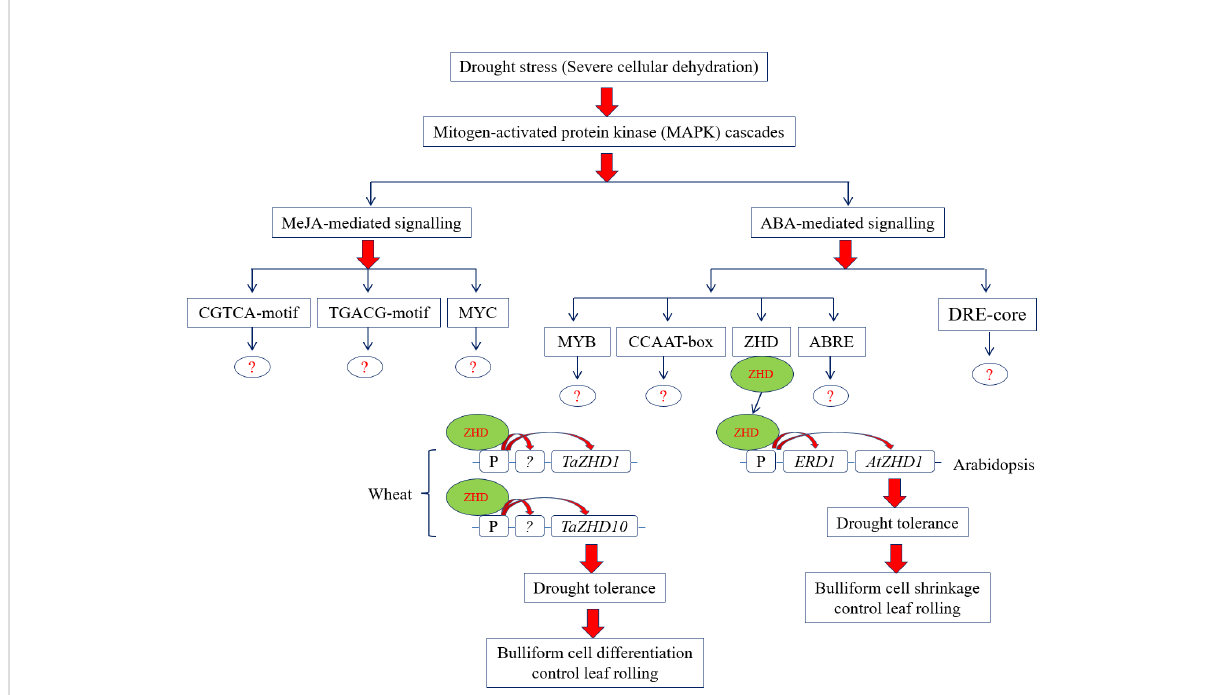
FIGURE 10 Proposed metabolic and gene regulatory model of leaf rolling under severe drought stress condition in